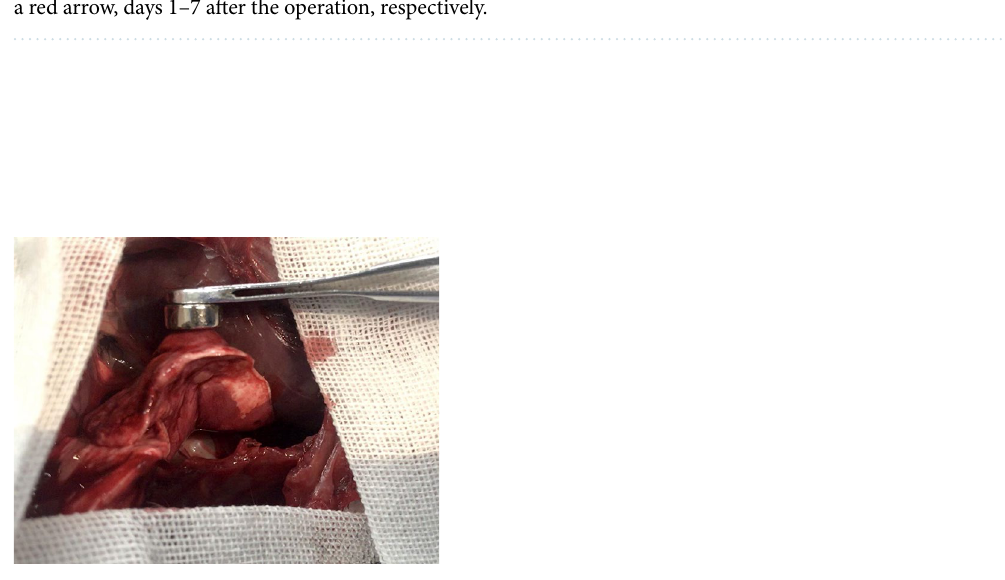
Figure 10. Lung tissue attracted by the pursuit